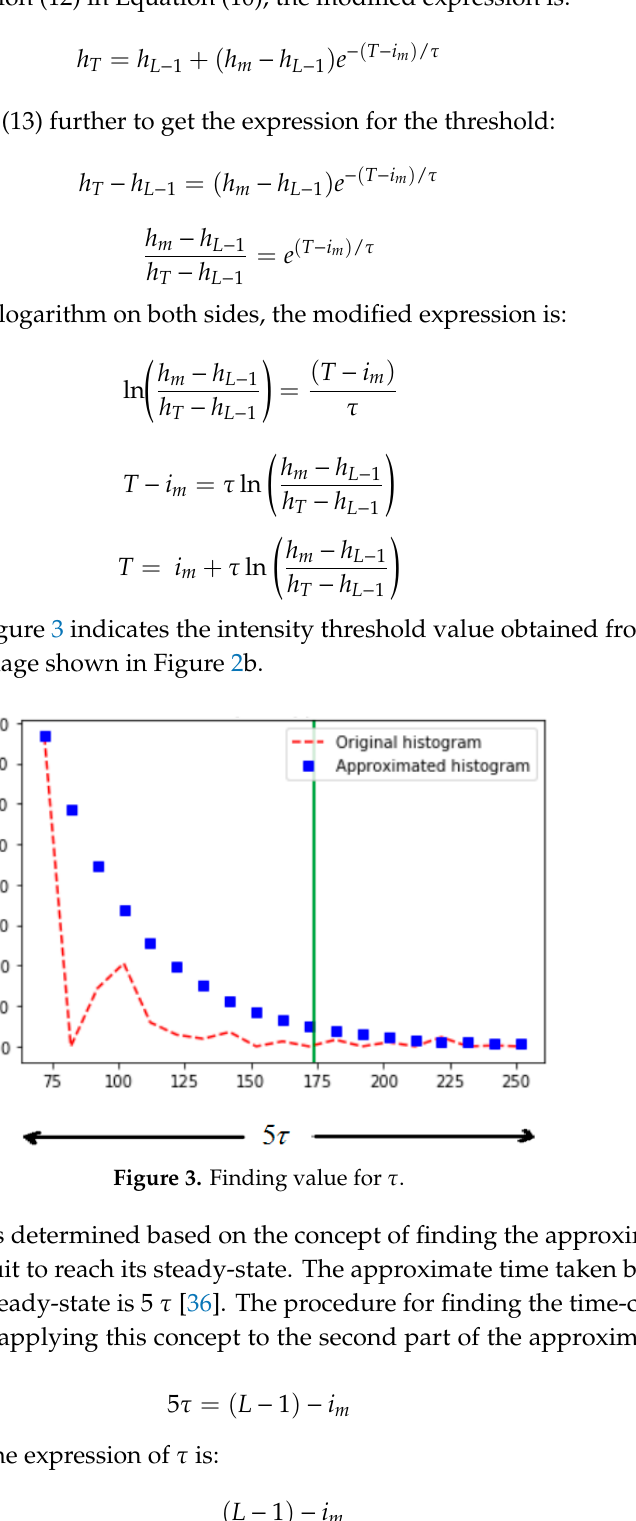
Figure 3. Finding value for 𝜏 .